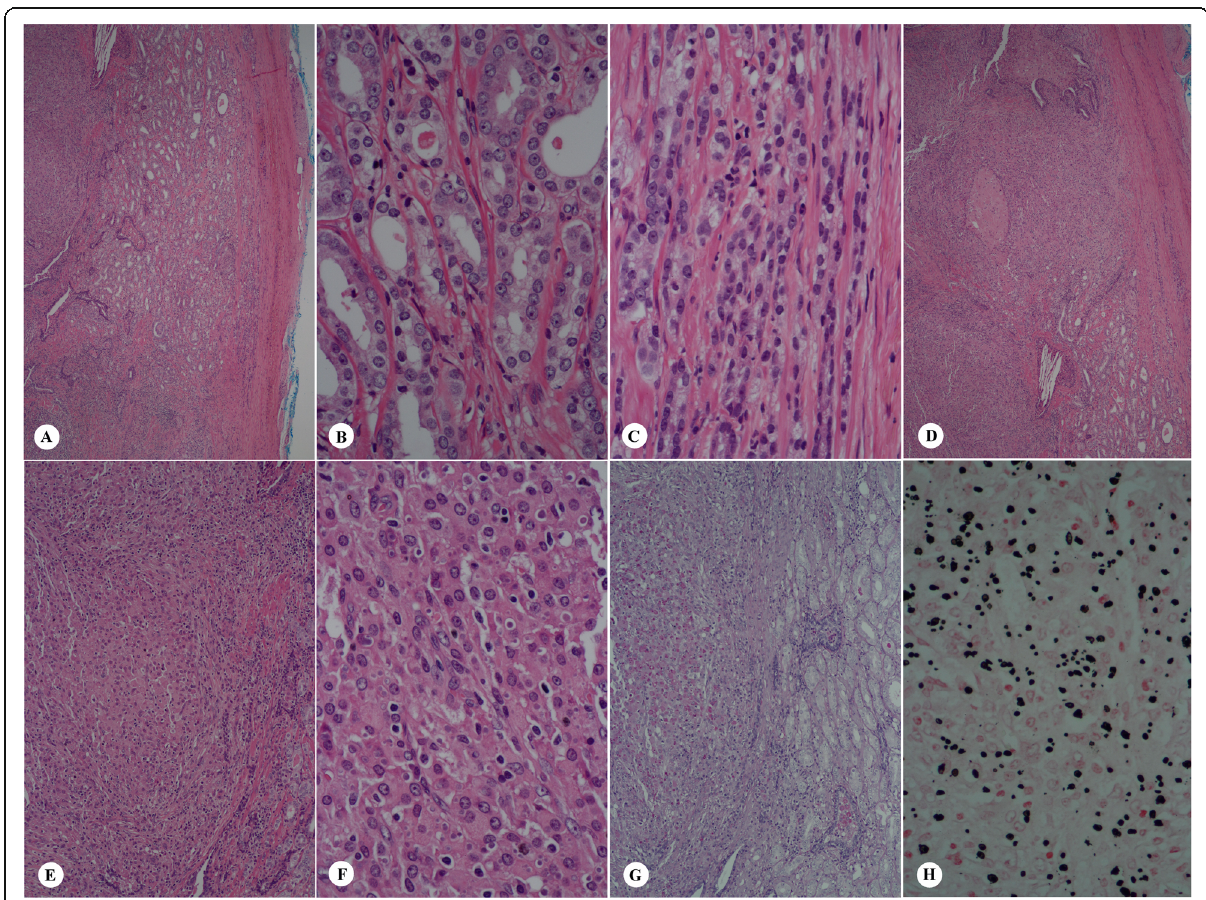
Fig. 1 Case 1. Prostatic adenocarcinoma associated with malakoplakia. Unifocal GG2 adenocarcinoma merging a solid lesion ( a HE, 40x). Detail of well differentiated glands of predominant Gleason pattern 3 ( b HE, 400x) and poorly formed glands ( c HE, 400x). A photomicrograph show a predominant solid lesion with an adenocarcinoma focus in the bottom ( d HE, 40x). At higher magnification, transition between adenocarcinoma and solid lesion with histiocytoid appearance ( e HE, 100x). Round basophilic inclusions are readily identified in HE stain within the cytoplasm of histiocytes ( f HE, 400x). PAS stain in the transition zone highlights strong staining in malakoplakia ( g PAS, 100x). Round inclusions (Michaelis – Gutmann bodies) are strongly positive by von Kossa stain ( h von Kossa,